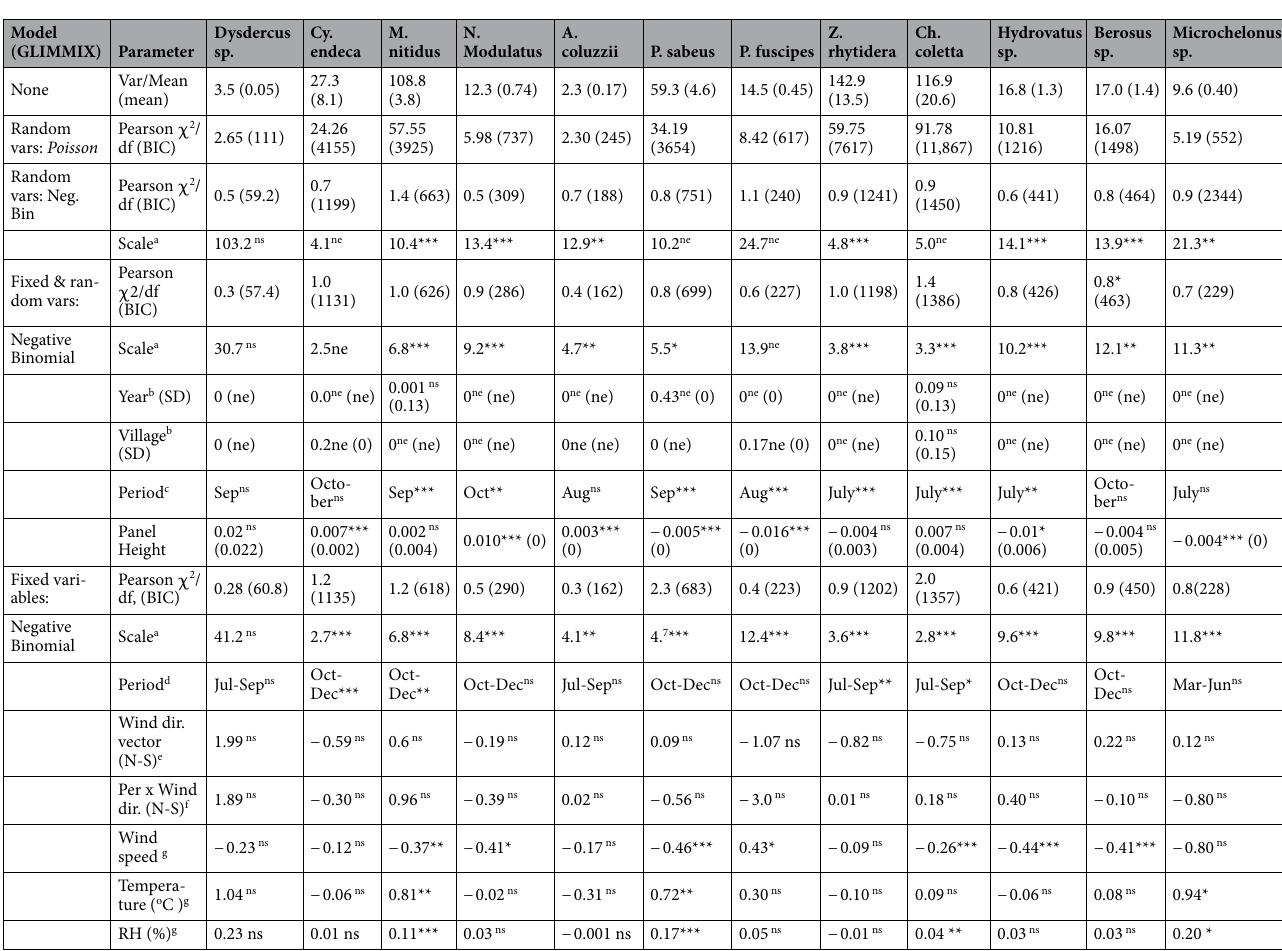
Table 3. Variation in taxon’s aerial density among years, locality (villages), altitude, and meteorological conditions (GLIMMIX models of random (year and village) and fixed (season, panel height, wind speed and direction, temperature and RH at flight height, 222 nets between 40 and 290 m agl, in 125 sampling nights). a For negative bionomial scale parameter estimates the k parameter of this distribution. b The effects of year and village could not be estimated simultaneously, so the estimates were produced in two separate models, each including only one of the factors. c Two month periods were used (Mar-Apr, May-Jun, Jul-Aug, Sep- Oct, and Nov-Dec). The period of highest panel density is shown with its statistical significance. *** , ** , * , ns, ne refer to significance probability of 0.001, 0.01 and 0.05, > 0.05, and to parameters that could not be estimated, respectively. d To better reflect seasonal variation in wind direction (Fig. 5a), periods for this analysis were Mar-Jun, Jul-Sep, and Oct-Dec. The period of highest panel density is shown with its statistical significance. e The main effect of wind direction, measured from south (− 1) to north (1) of each sampling location on aerial density. This measures the south-north component of the average angle of nightly wind direction (see text and Fig. 5a). f The interaction between Period and S–N vector of wind is shown for the difference between Oct-Dec and Jul-Sep. g Measured at flight altitude using MERRA2 database based on panel height (see text for